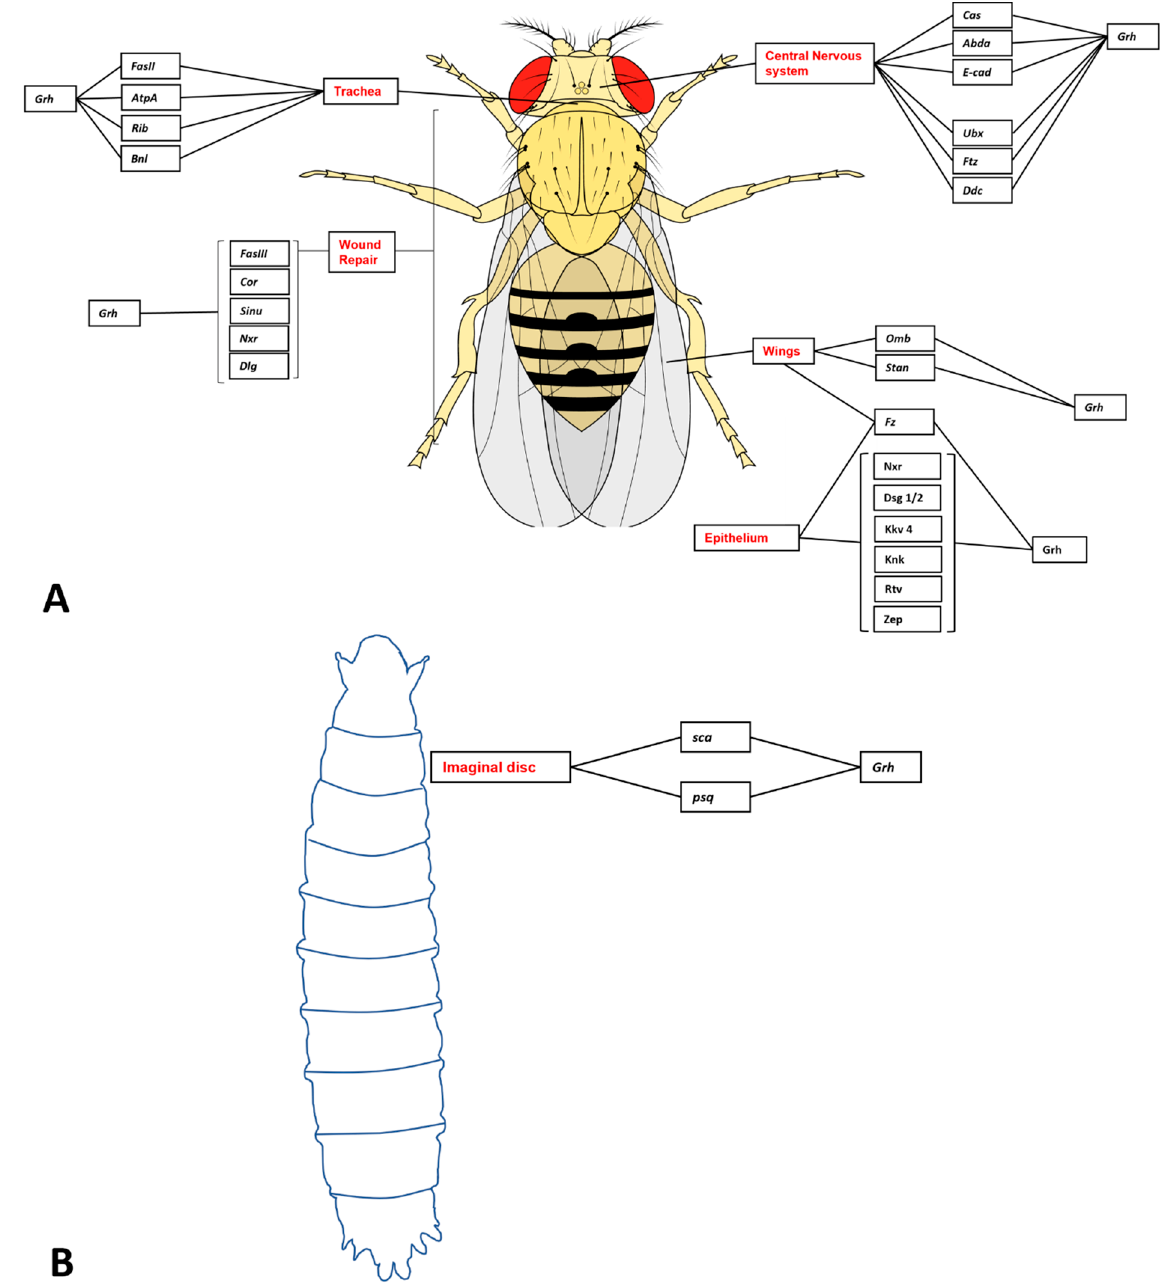
Figure 4. Grainyhead-like target genes in Drosophila adults and larvae. ( A ) Adult Drosophila target genes. Grh regulates tracheal branching through the target genes FasII, AtpA, Rib and Bnl. Expression of Grh in the amnioserosa results in tissue closure defects as a result of regulation of FasII, Cor, Sinu, Nxr and Dlg. Grh also regulates Cas in the differentiation of neuroblasts, as well as Abda and E-cad. Grh also regulates Ubx, Ftz and Ddc by binding to neurogenic enhancers on these genes. Grh regulates Stan and Omb in wing development, and the absence of these genes results in a ‘notched’ wing phenotype. Grh regulates a number of processes in the epithelium, including wound repair, junction and barrier integrity and development. This is achieved through the genes Nxr, Dsg1/2, Kkv, Knk, Rtv and Zep. ( B ) Grh target genes in Drosophila larvae development. Grh regulates the genes Sca and Psq, which are responsible for development of the imaginal disc and by extension, the development of the adult fly from the larvae following metamorphosis.